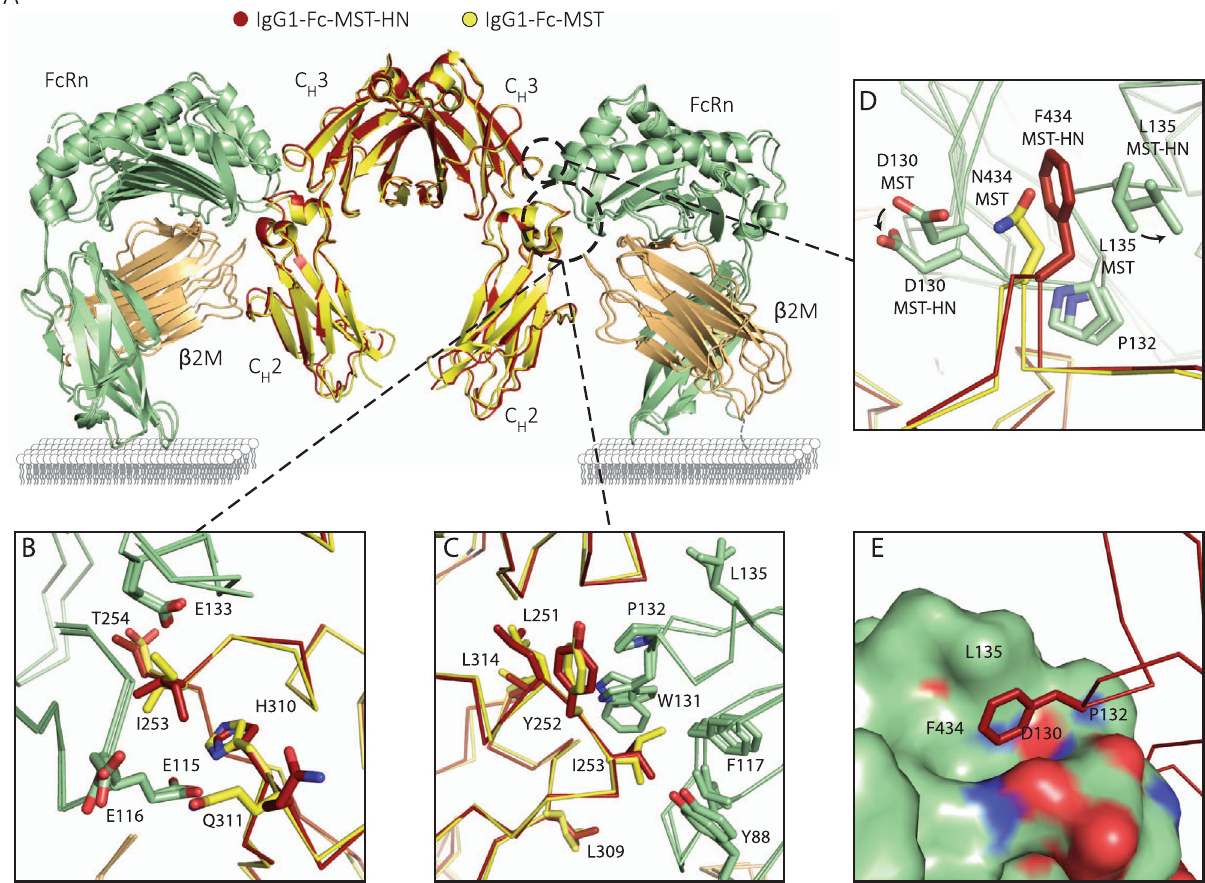
Fig. 2 | Fc-MST-HN combines a larger hydrophobic-binding epitope on FcRn than on Fc-MST 50 with the expected upside-down mode of interaction. A Superposition of the crystallographic models of complexes between FcRn:ß2M (green and orange) and Fc-MST (yellow) or Fc-MST-HN (red), displayed in cartoon representation.The linkerregion connecting the extracellularregion of FcRn to its transmembrane domain is represented as a dashed line. If present, Fab moieties would be oriented downwards and sterically clash with the membrane, which is shown for clarity. Detailed view of superimposed residues that contribute ( B ) electrostatically and ( C ) hydrophobically to the Fc:FcRn interface. Main chains are